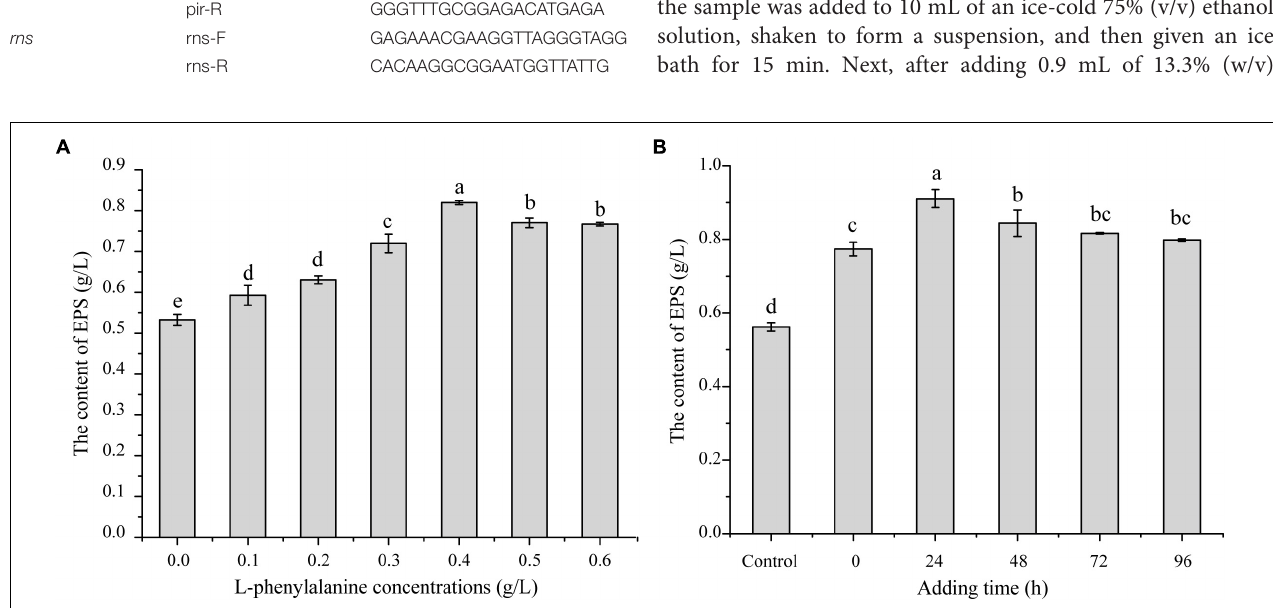
FIGURE 1 | The effect of L-phenylalanine on EPS production in G. lucidum . (A) Effects of L-phenylalanine concentrations on EPS. (B) Effects of L-phenylalanine (0.4 g/L) addition at different stage on EPS [the different superscript letters (a, b, c, d) in each column indicate significant differences at the P < 0.05 level].